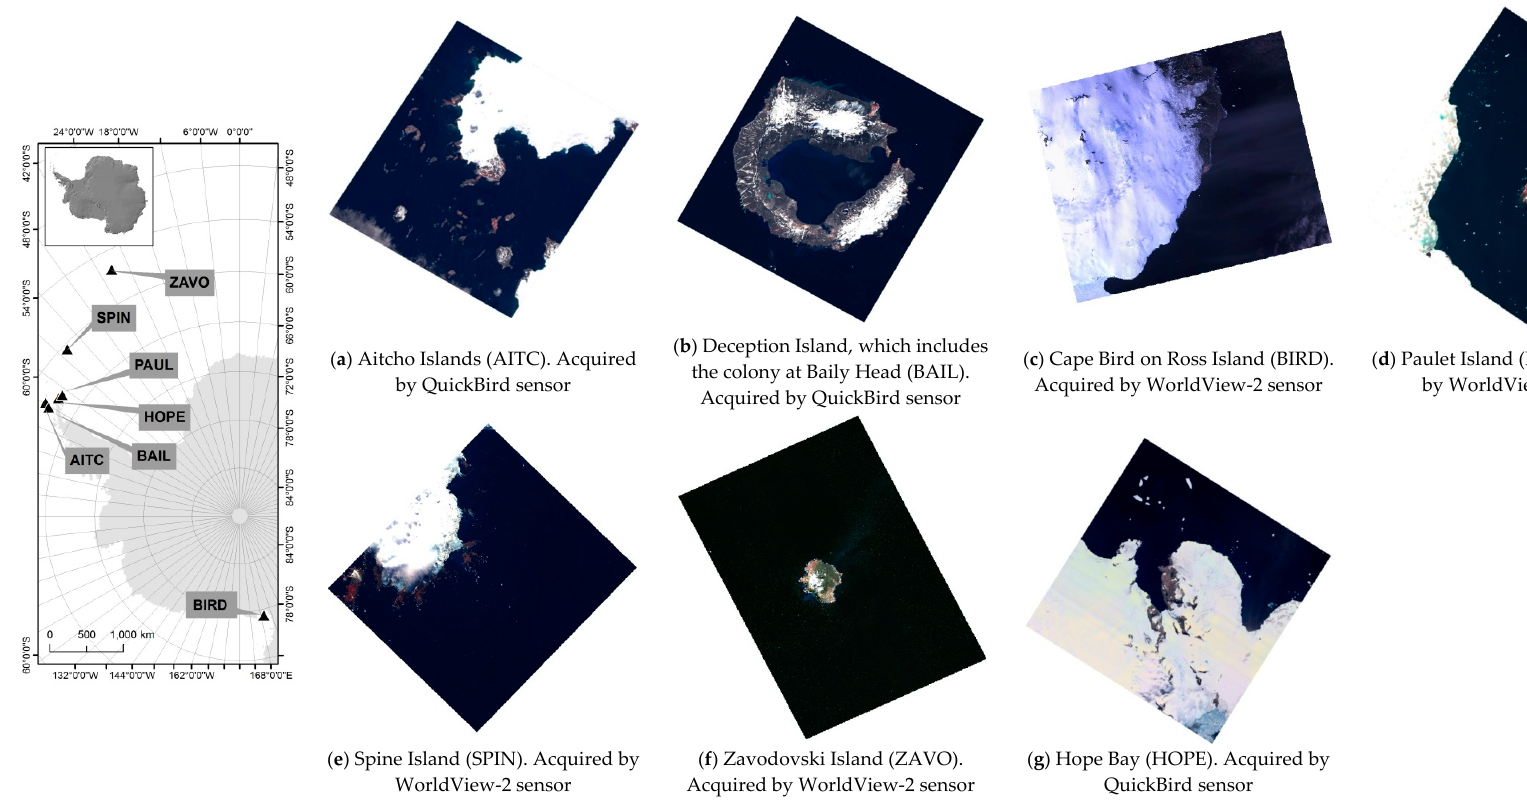
Figure 1. Geographical setting of study sites and candidates image scenes: ( a ) Aitcho Islands ( b ) Deception Island ; ( c ) Cape Bird on Ross Island ( d ) Paulet Island; ( e ) Spine Island; ( f ) Zavodovski Island; and ( g ) Hope Bay . Imagery copyright DigitalGlobe, Inc., Westminster, CO, USA.